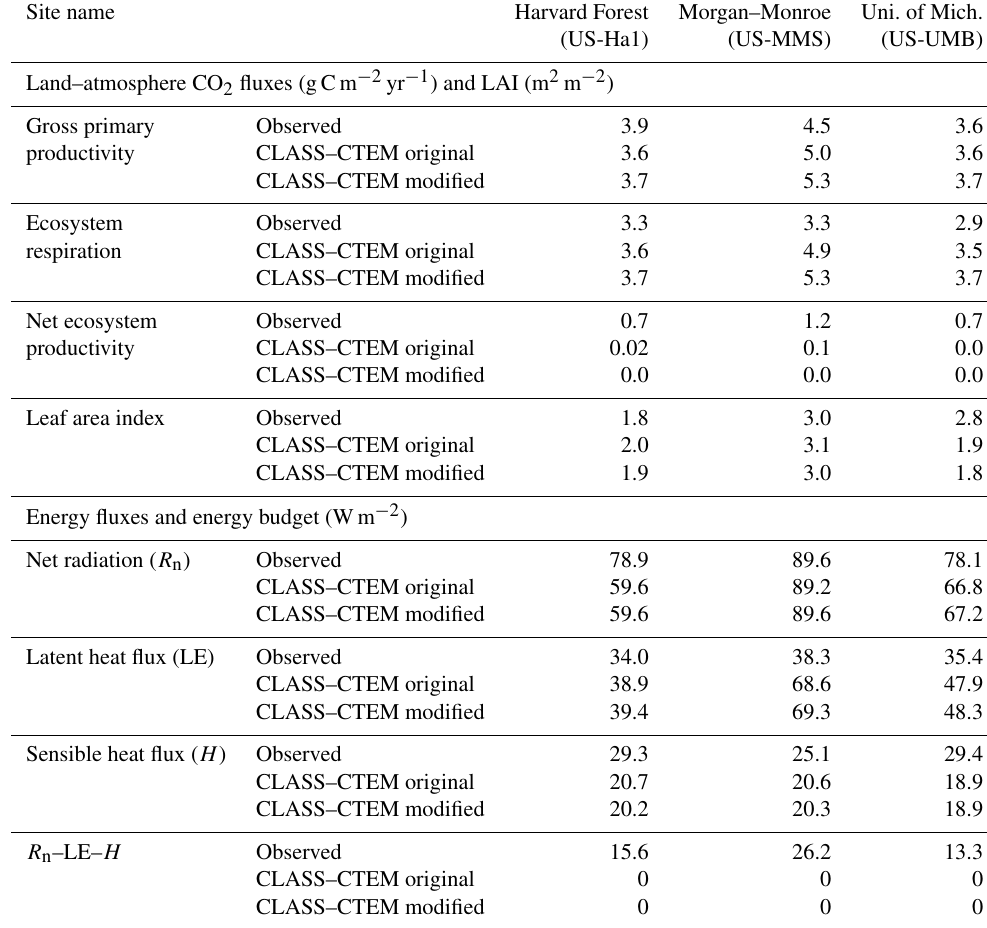
Table 3. Simulated and observation-based turbulent energy and carbon fluxes and LAI at the three FLUXNET